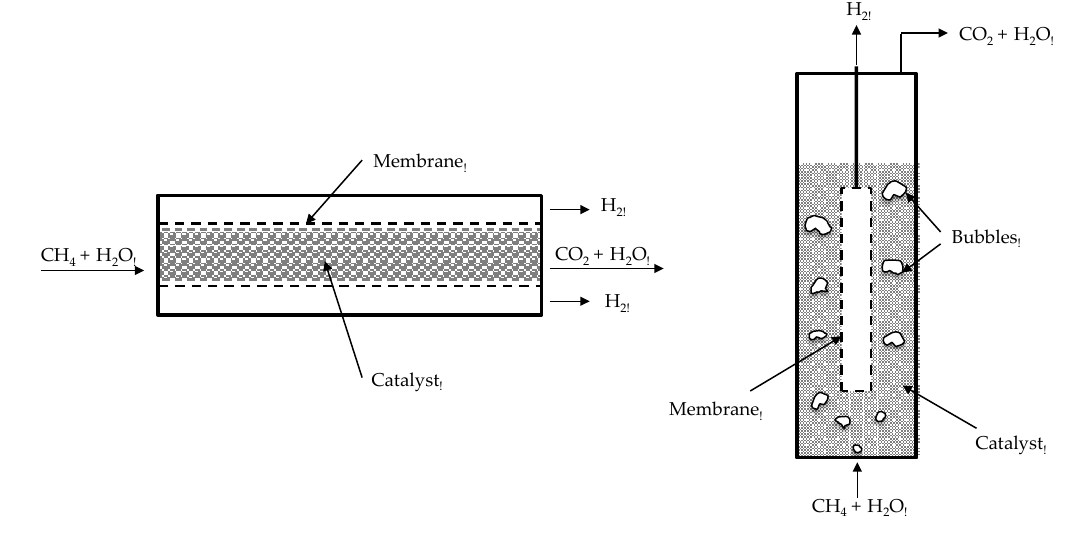
Figure 1. Schematic representation of packed-bed ( left ) and fluidized-bed ( right ) membrane reactors.